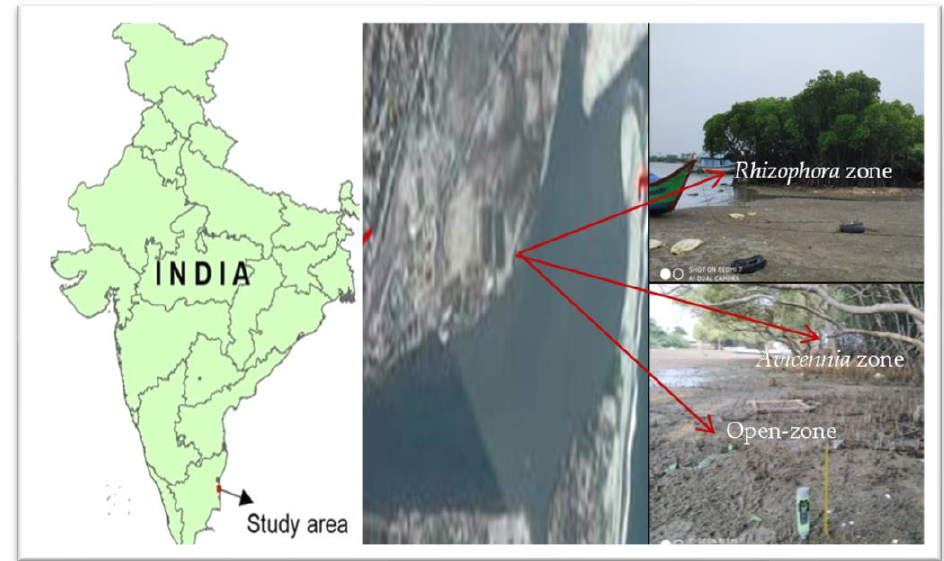
Figure 1. Study area along a restored mangrove forest in the Vellar estuary, southeastern India.